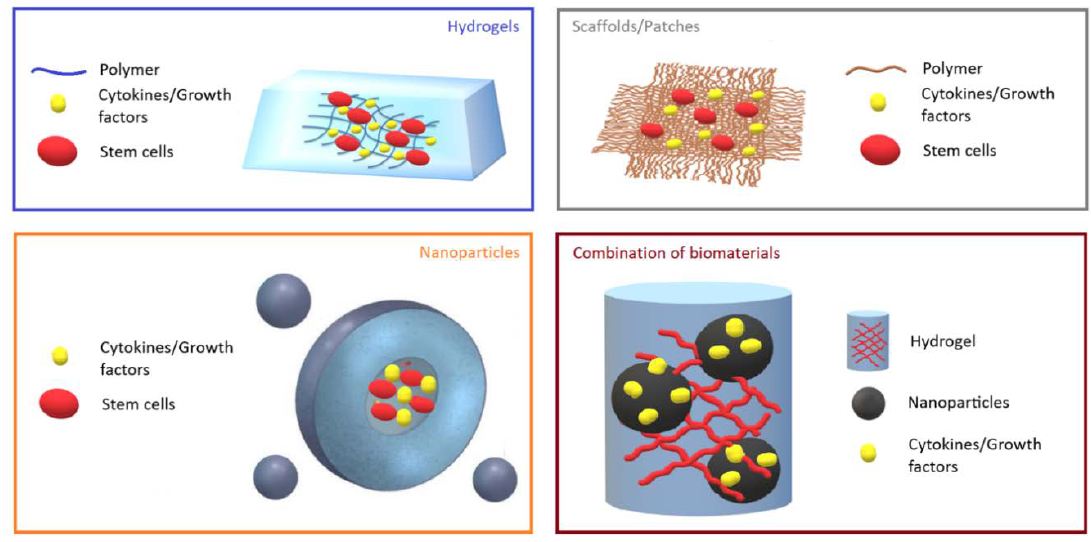
Figure 1. Representative images of biomaterials. Hydrogels, scaffolds/patches, and nanoparticles loaded with growth factors/cytokines and stem cells, and their combination are shown.